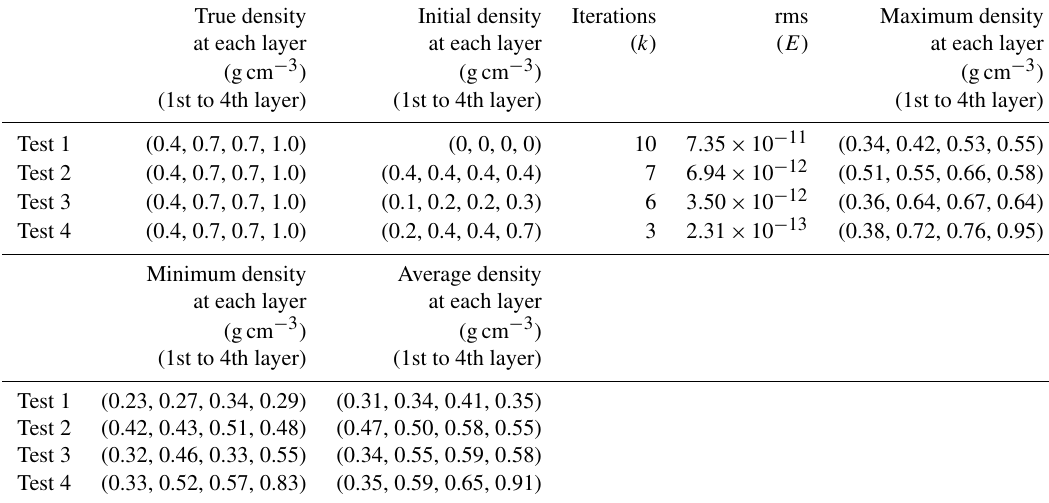
Table 1. Conditions and results for initial density model